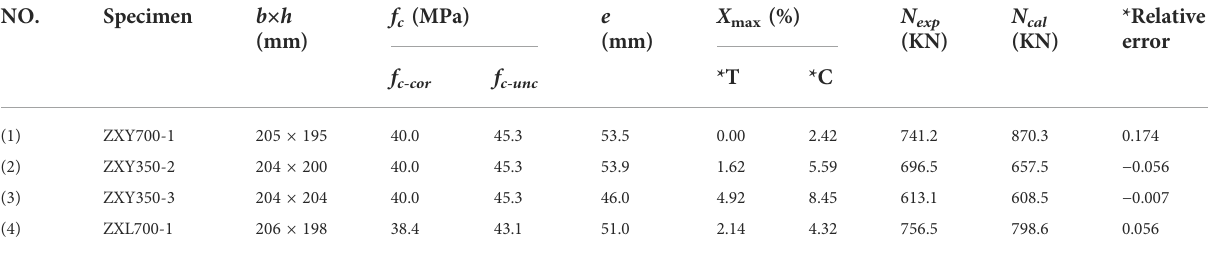
TABLE 2 Comparison of the predicted residual load capacity of the corroded RC column with experimental data available. NO.